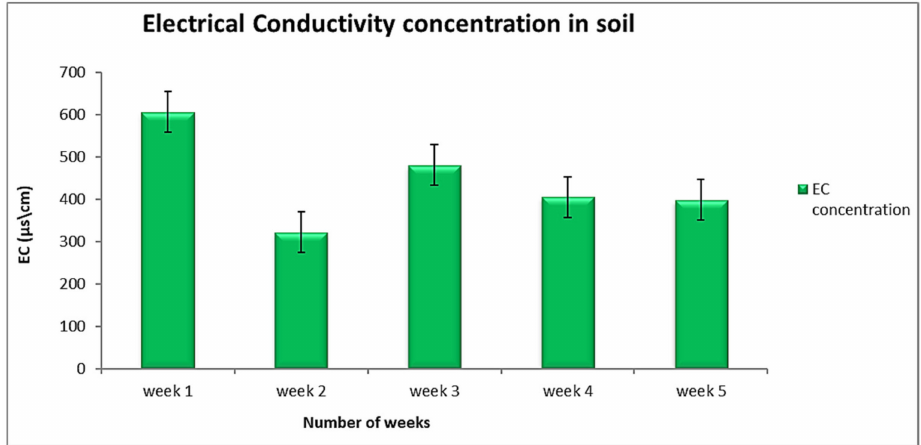
Figure 2. The electrical conductivity results in the soil for the five weeks sampling period.